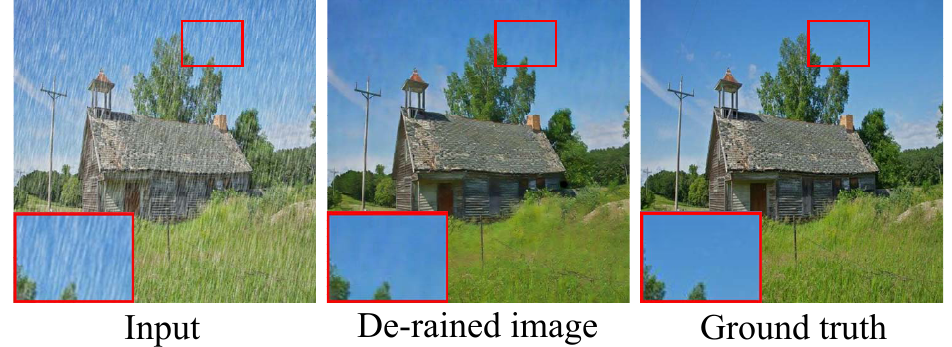
Figure 5. An example of rain residue after de-raining. It can be seen that the zoomed area still has rain residue which should be